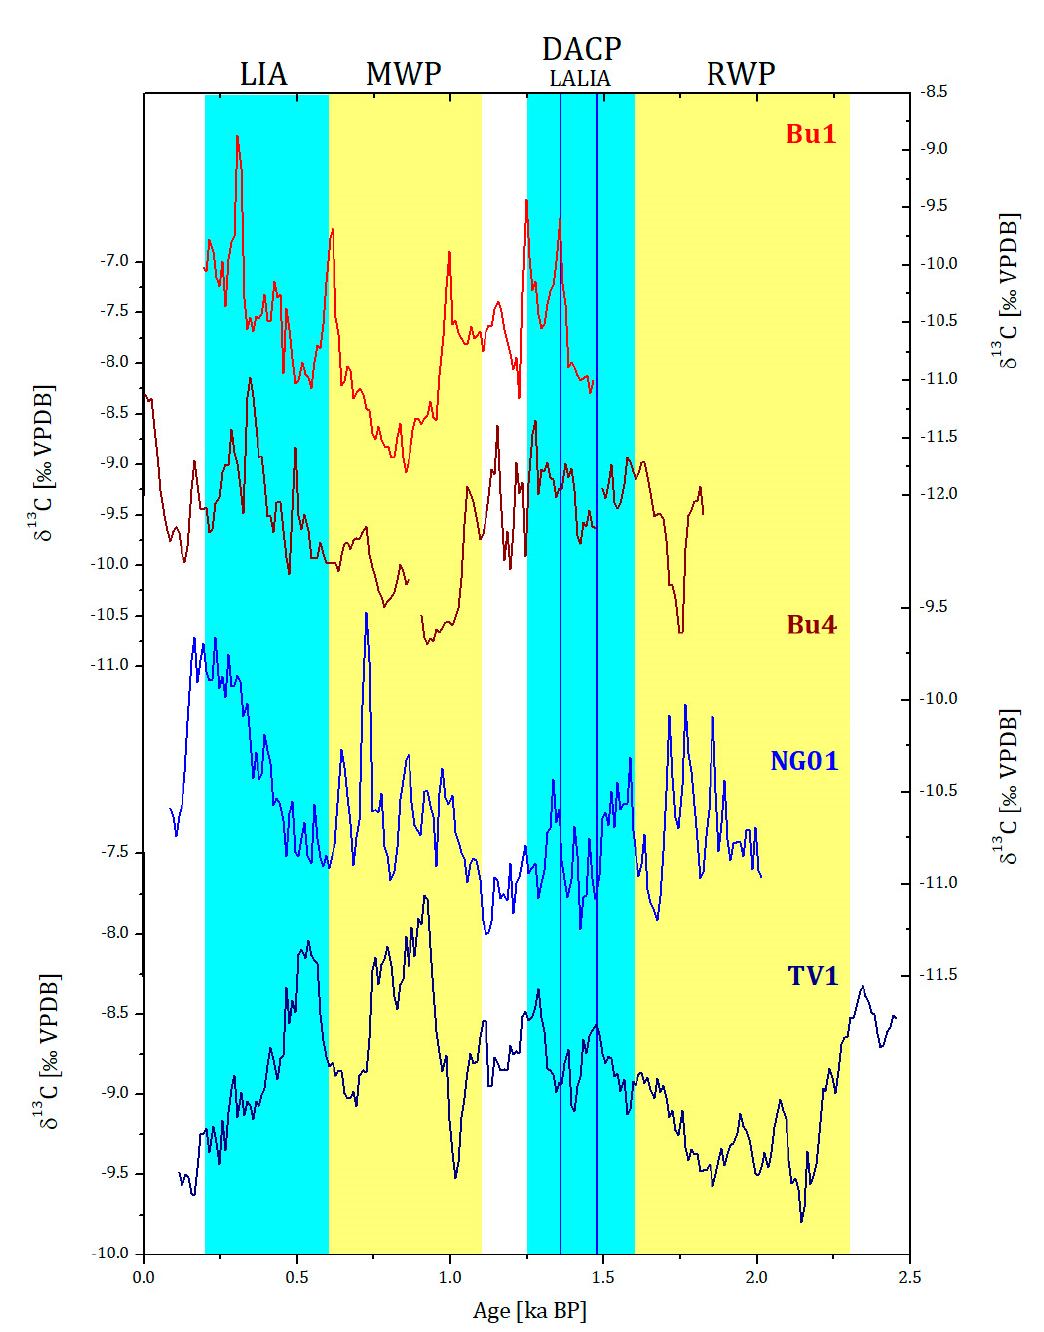
Figure 9. δ 13 C records of all four speleothems with a temporal resolution of 10 years. Yellow bars indicate the Medieval Warm Period (MWP) and the Roman Warm Period (RWP) as periods with warm and humid climate, and blue bars indicate the Little Ice Age (LIA), the Dark Ages Cold Period (DACP) and the Late Antique Little Ice Age (LALIA) as periods with cold and dry climate. Timing and duration of these cold and warm phases are shown as described in the literature